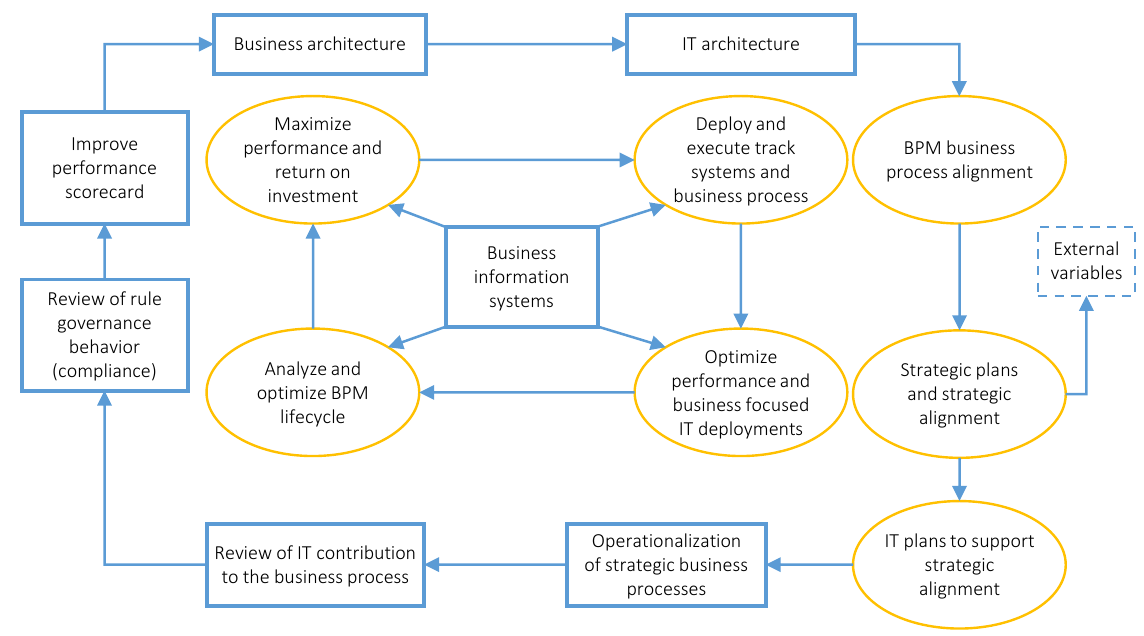
Figure 1. IT alignment